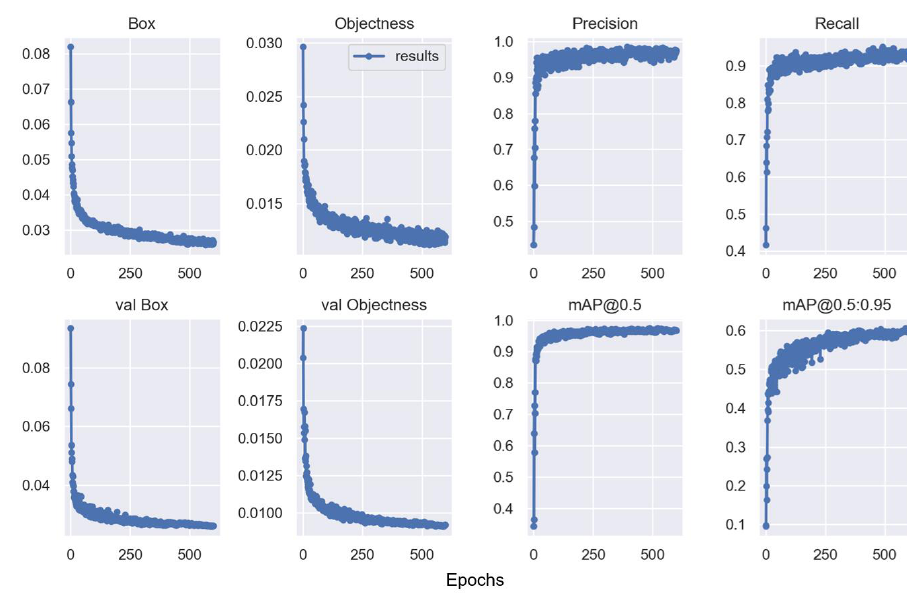
Figure 13. The relationship between loss, precision, recall, mAP, and epoch.